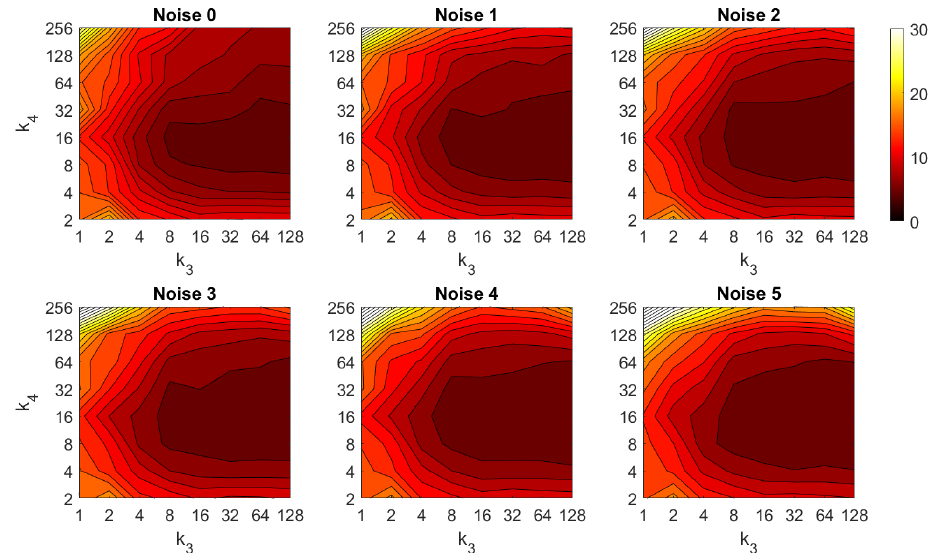
Figure 30. FS orientation estimation in the presence of noise. Average orientation error (deg).